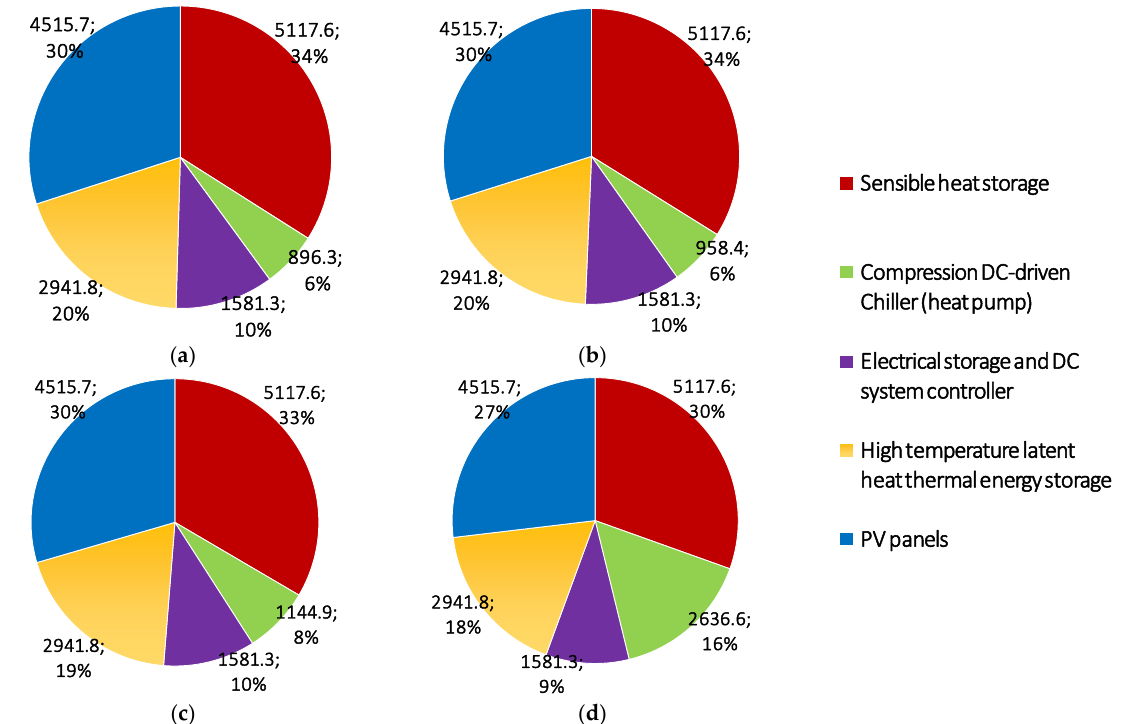
Figure 7. Contribution of the refrigerant to the overall system change in the refrigerant lifespan: ( a ) 15 years; ( b ) 10 years; ( c ) 5 years; ( d ) 1 year.